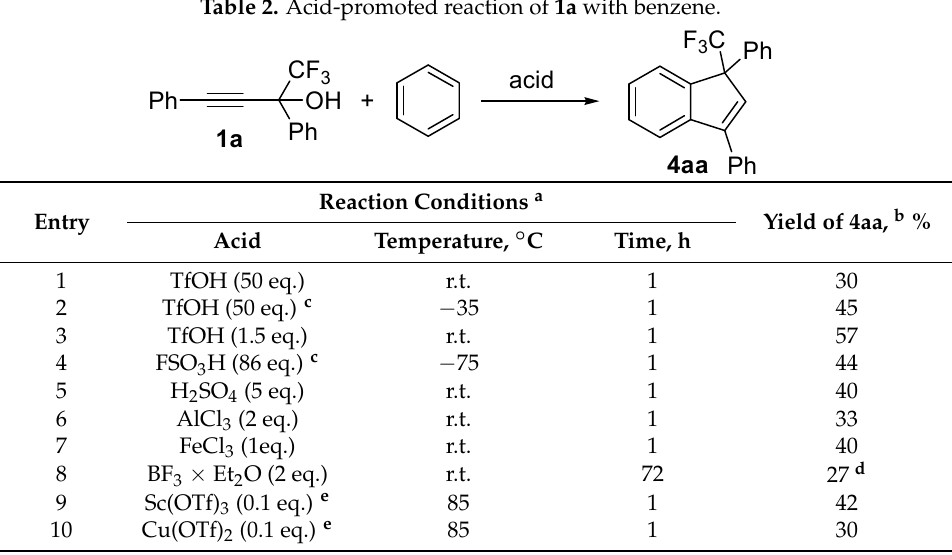
Molecules 2018 , 23 , 3079 5 of 22